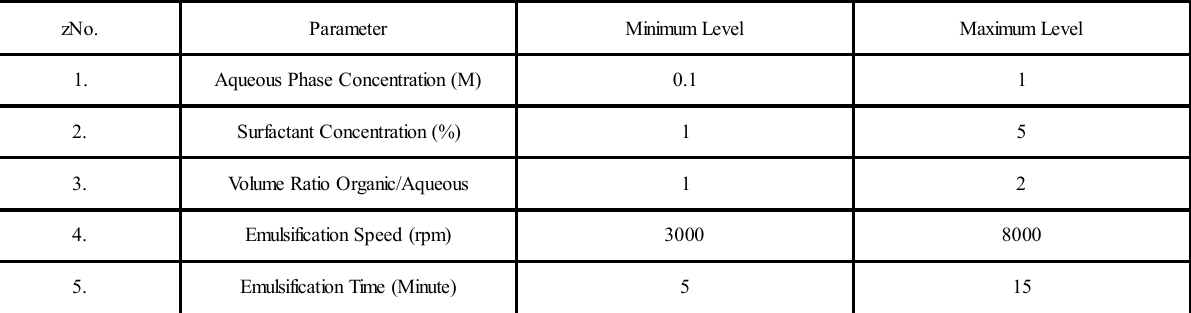
TABLE 1. PARAMETERS AND LEVELS